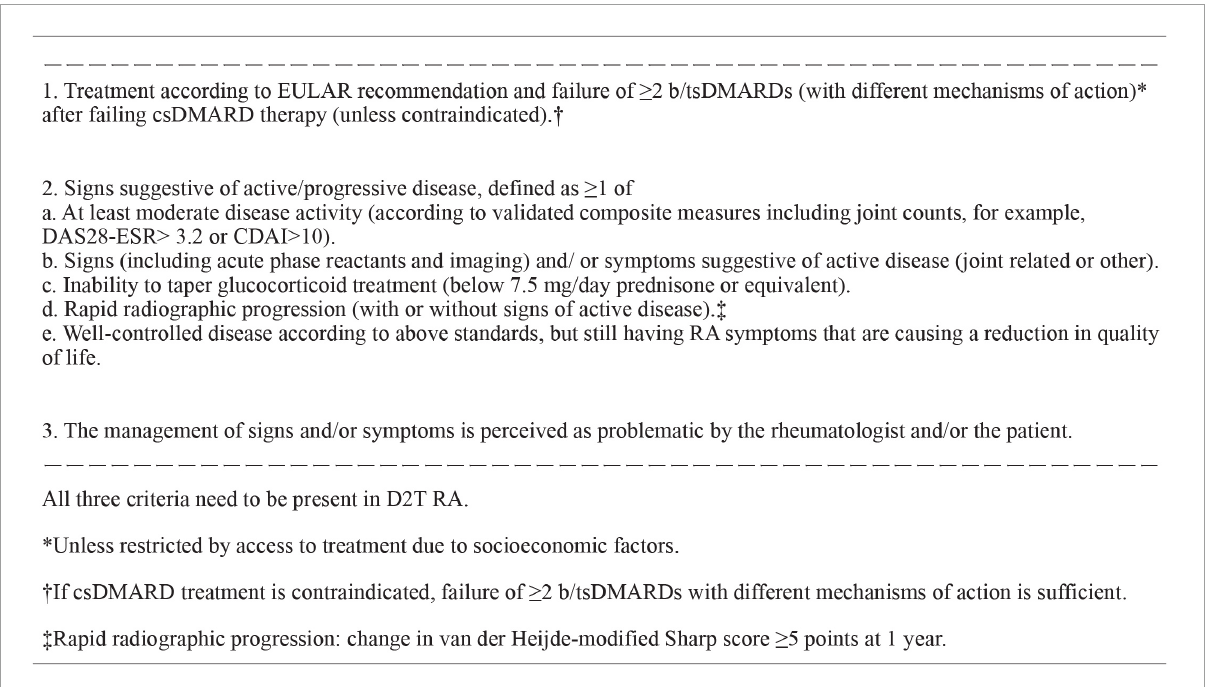
FIGURE1 EULAR definition of difficult-to-treat RA. b/tsDMARDs, biological or targeted synthetic disease-modifying antirheumatic drug; CDAI, clinical disease activity index; CS, conventional synthetic; DAS28-ESR, disease activity score assessing 28 joints using erythrocyte sedimentation rate; D2T RA, difficult-to-treat rheumatoid arthritis; EULAR, European League Against Rheumatism; RA, rheumatoid